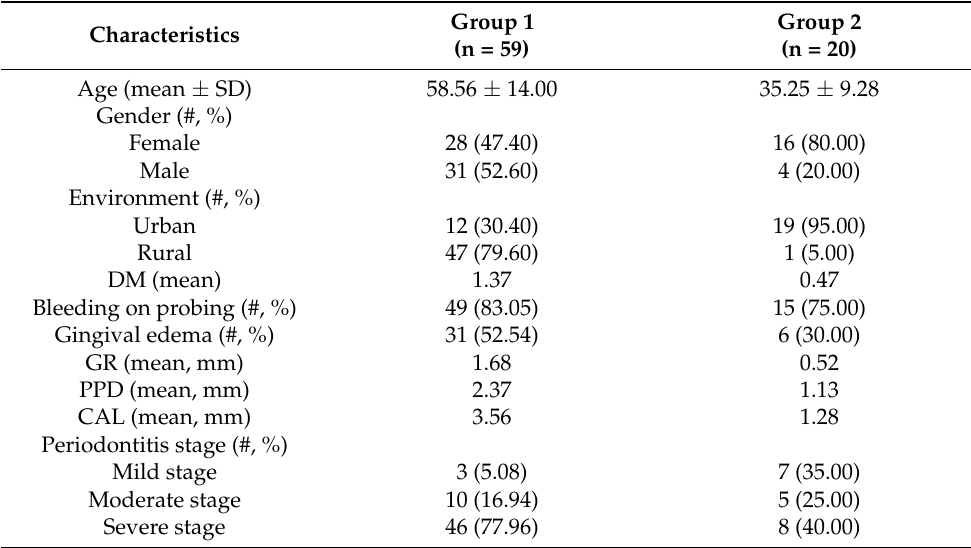
Table 1. General and periodontal characteristics within the study and control groups.